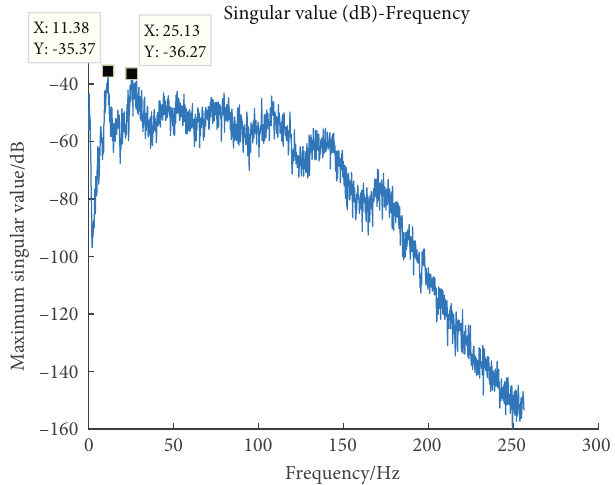
Figure 17: Maximum singular value of the horizontal tail.